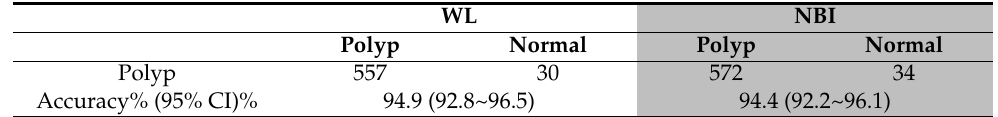
Table 14. Polyp size ≤ 0.5